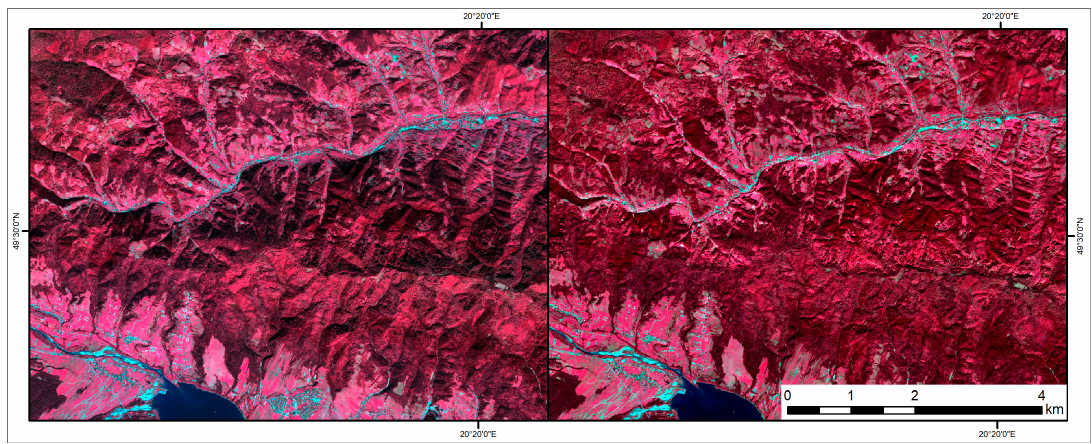
Figure 3. A subset of the Sentinel-2 image acquired on 2 October 2017 (band combination 8, 4 and 3), on the left: Level-1C—before and on the right: Level 2A after atmospheric and topographic correction.